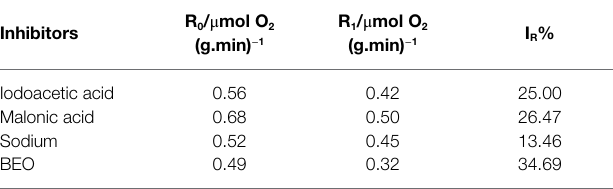
TABLE 1 | The respiratory inhibitory rate of basil essential oil (BEO) and typical inhibitors.